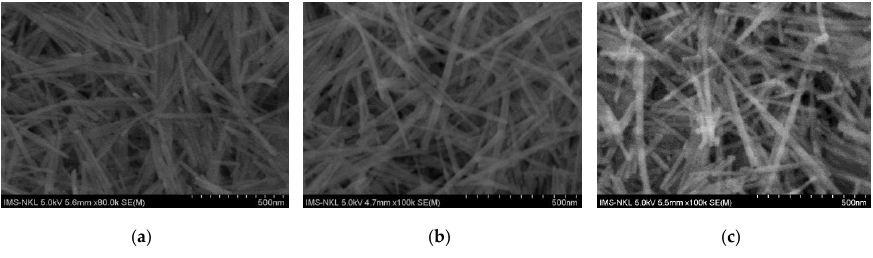
Figure 1. FESEM images of the produced nanomaterials: ( a ) TbPO 4 ·H 2 O nanorods, ( b ) TbPO 4 ·H 2 O@silica-NH 2 ; ( c ) TbPO 4 ·H 2 O@silica-NH 2 -mAb^CD133-mAb^PD-L1 nanocomplex ( TMC ).